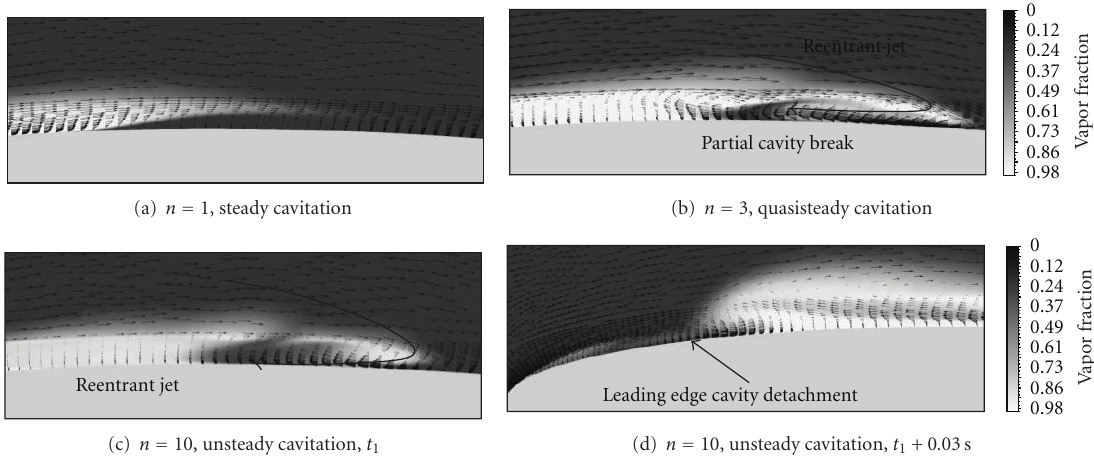
Figure 5: Comparison of the vapor fraction contours and velocity vectors for di ff erent n values with the Merkle model at σ = 1 . 49, Re = 750,000, V ∞ = 5m/s, and α = 6 ◦